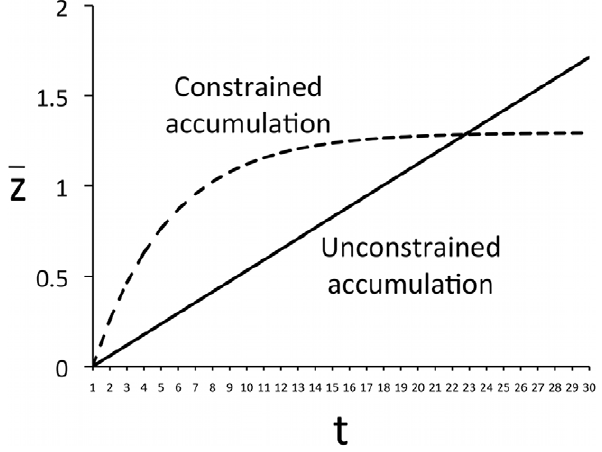
Figure 3. Cultural accumulation over successive generations in Henrich’s [ 20 ] original unconstrained model (Eq. 1) and in the constrained Model 1 (Eq. 2). Parameters: N =100, a =0.2, b =0.05.